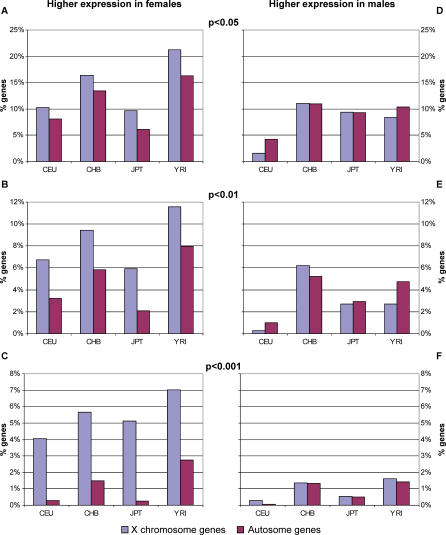
The Proportion of Genes with Higher Female Expression Is Greater from X Than AutosomesPercentage of X chromosome and autosome genes showing higher expression in females (A–C) or males (D–F) at three levels of significance: p < 0.05, p < 0.01, and p < 0.001. Note that the y-axis scale changes for different levels of significance.